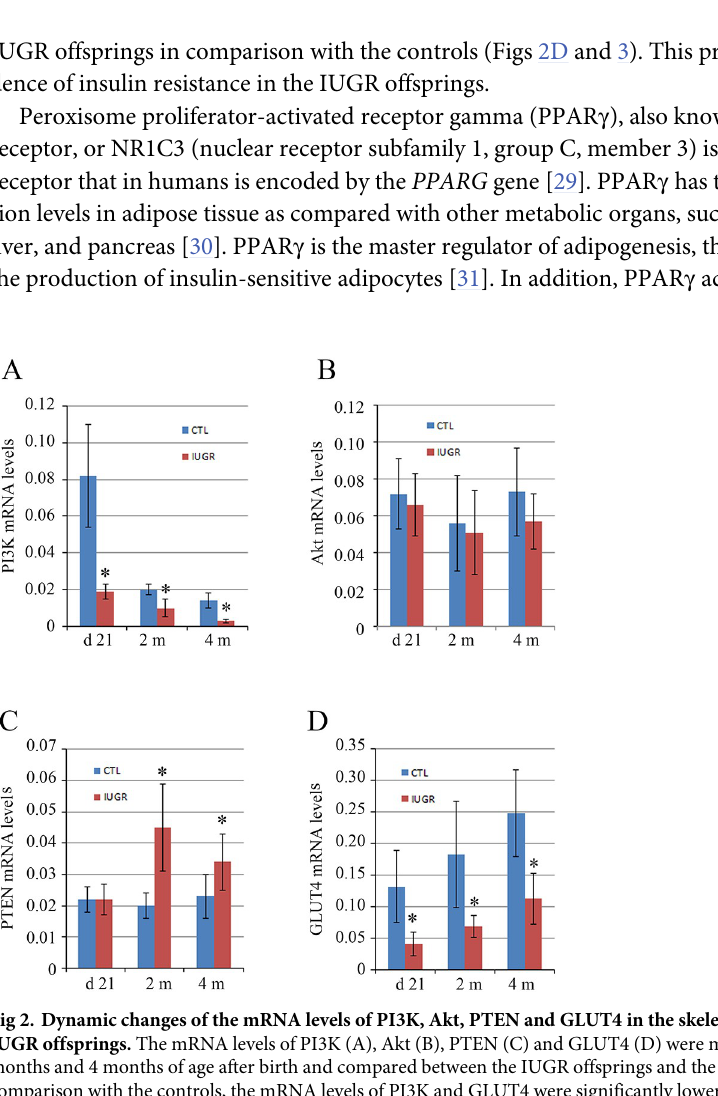
Fig 2. Dynamic changes of the mRNA levels of PI3K, Akt, PTEN and GLUT4 in the skeletal muscle tissue in the IUGR offsprings. The mRNA levels of PI3K (A), Akt (B), PTEN (C) and GLUT4 (D) were measured at 21 days, 2 months and 4 months of age after birth and compared between the IUGR offsprings and the controls (CTL). In comparison with the controls, the mRNA levels of PI3K and GLUT4 were significantly lower at all three time points in the IUGR offsprings. At 2 and 4 months, PTEN mRNA levels were higher in the IUGR offsprings than that in the controls. Akt mRNA levels did not show significant difference between the IUGR offsprings and the controls. Data are shown as mean ± SD . n = 15 , � p < 0 . 05 vs . CTL